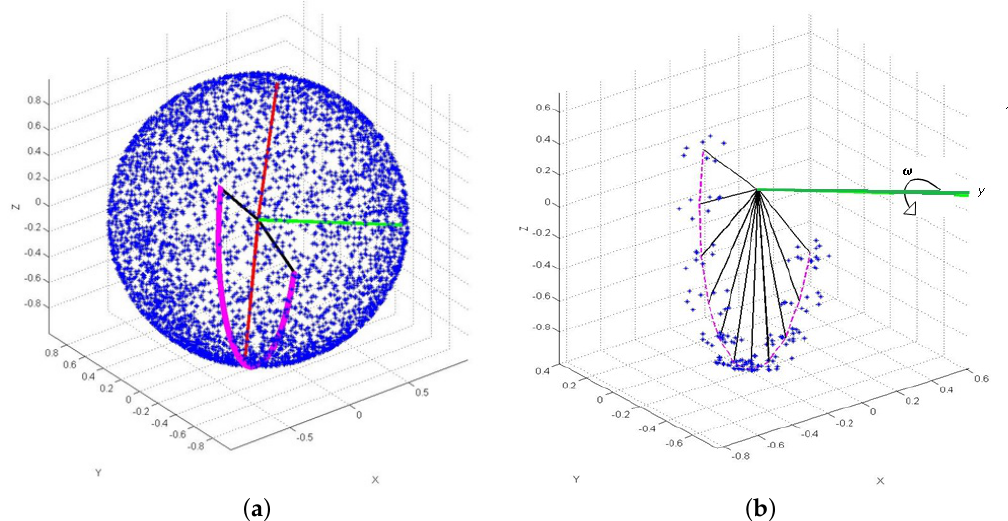
Figure 3. Stars view over the trajectory. ( a ) Stars sphere. ( b ) Observed stars by an orbiting